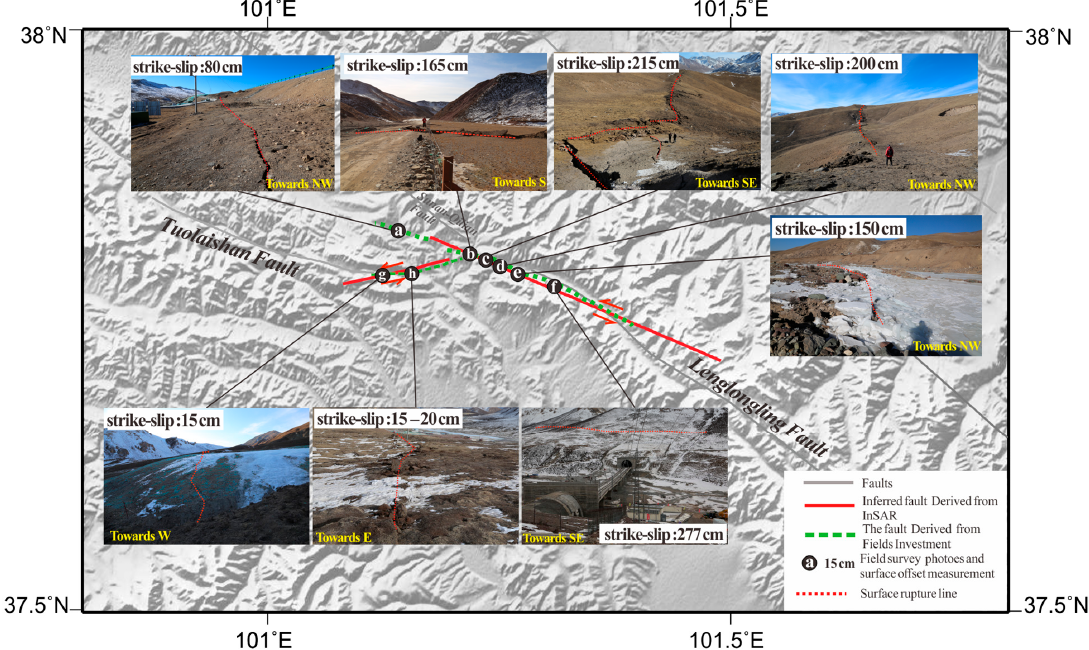
Figure 10. Surface rupture distribution derived from field measurements. Sites a–h are the selected locations for field measurements of surface ruptures.